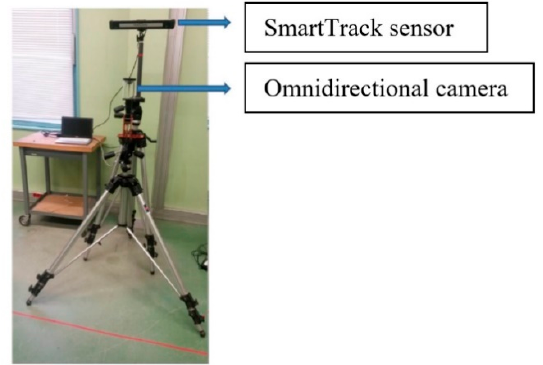
Figure 5. Data acquisition setup. The SmartTrack device and the Omnidirectional camera are mounted on a tripod. A calibration process was carried out to determine the rigid transformation between the two systems.